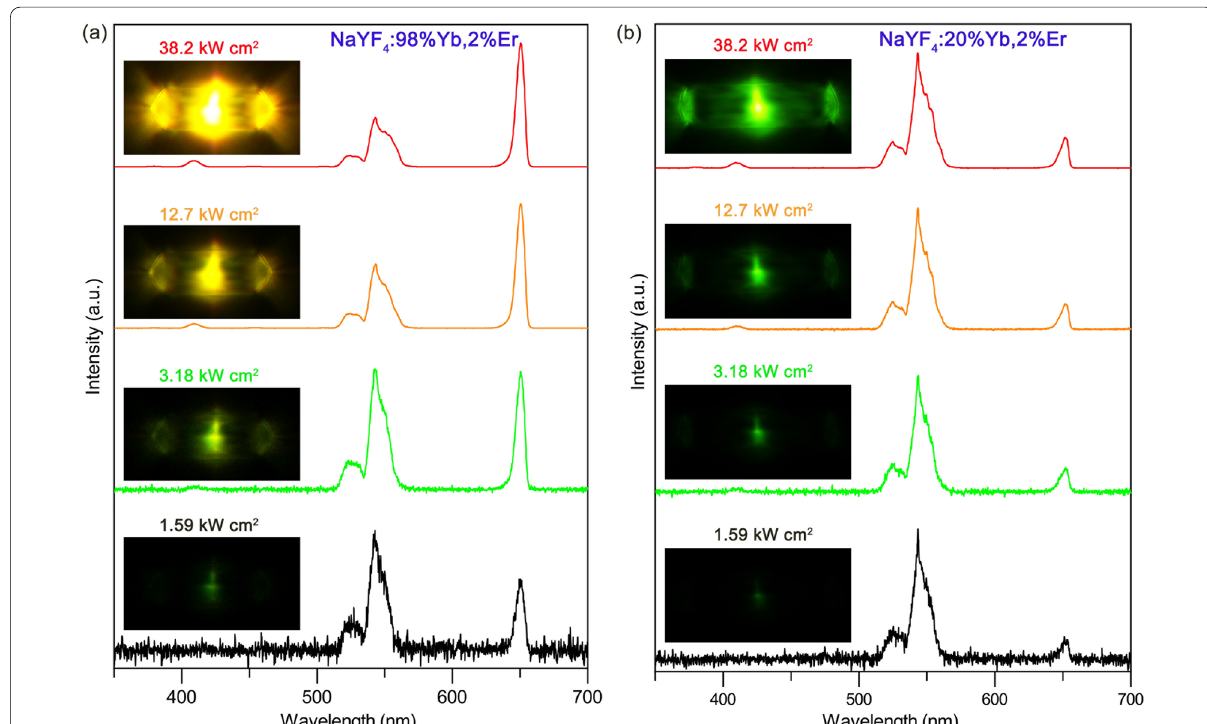
Fig. 2 The UCL spectra of single a β-NaYF 4 :98%Yb,2%Er, and b β-NaYF 4 :20%Yb,2%Er microcrystal under the excitation of 808 nm CW laser with different excitation density. The insert UCL photographs are corresponding to the relevant spectrum,